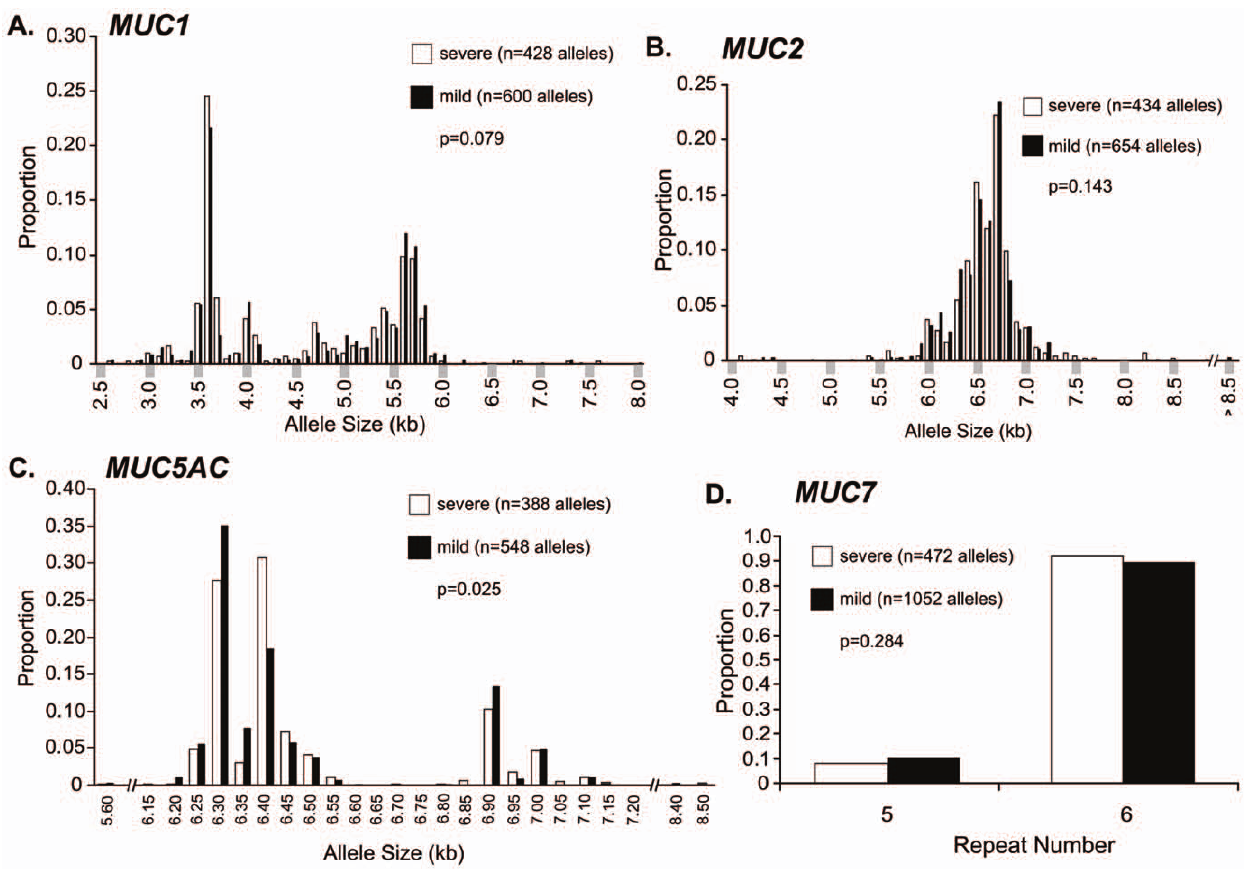
Figure 2. Distributions of VNTR allele sizes by lung severity status. Distributions of VNTR allele sizes by lung severity status for (A) MUC1 , (B) MUC2 , (C) MUC5AC , and (D) MUC7 are shown. The number of chromosomes (alleles) representing each phenotype category for each mucin is given (n), as is the Wilcoxon rank-sum test p value. doi:10.1371/journal.pone.0025452.g002 Table 1. Association of MUC5AC VNTR allele sizes with lung disease severity (‘‘Severe’’ versus ‘‘Mild’’) { .